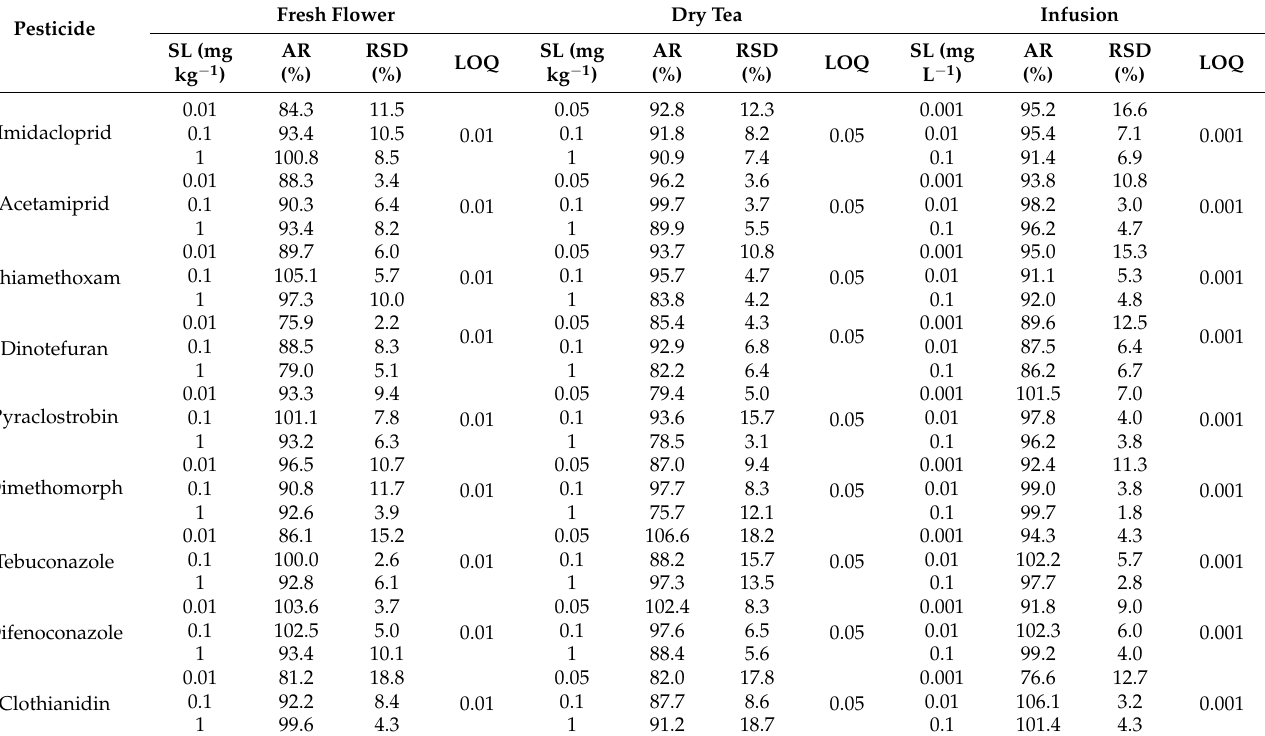
Table 3. The Average recoveries (AR, %, n = 5), Relative standard deviations (RSDs, %) and Limit of quantification (LOQs) of the 15 pesticides in different chrysanthemum matrices at three spiked levels (SLs).